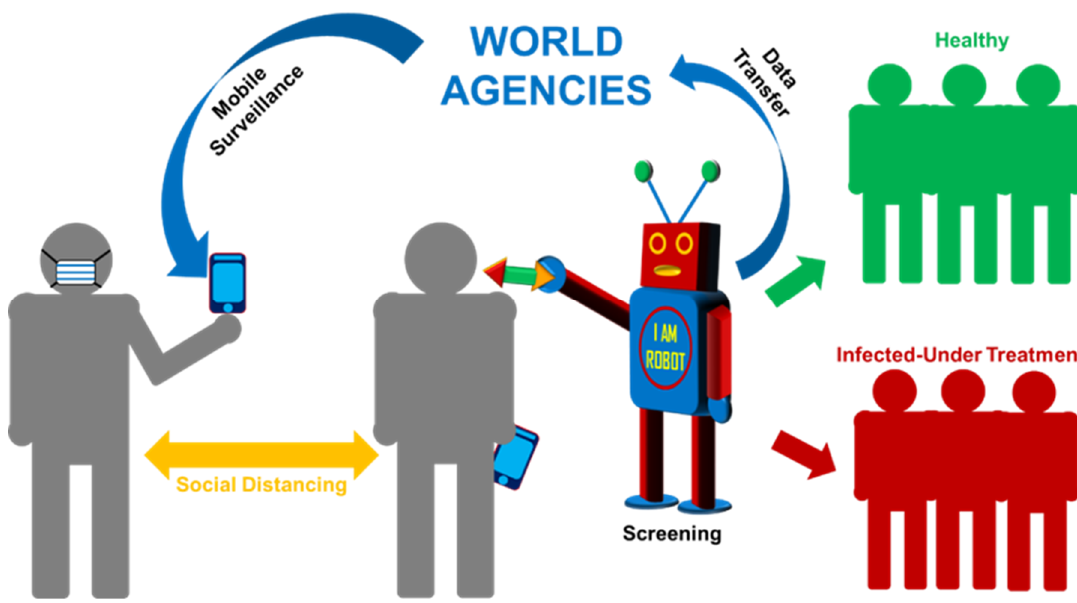
Figure 6. Possible preventive methodologies against infectious disease in future.